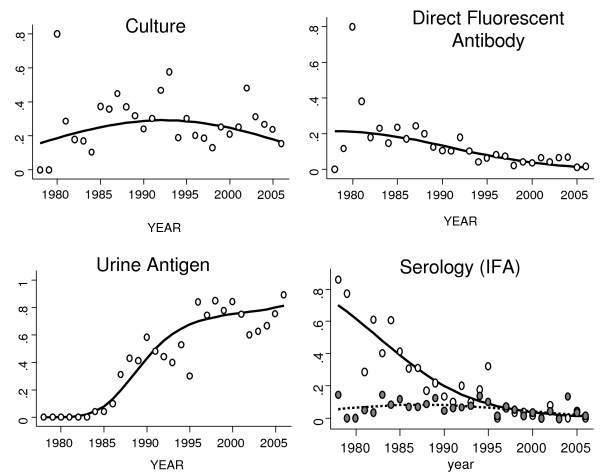
Changing Influence of Testing Methodologies on Legionellosis Diagnosis, Ontario, 1978–2006. Observed (dots) and expected (curves) probabilities of test positivity by methodology in 1401 cases of legionellosis diagnosed in Ontario, Canada from 1978 to 2006. In bottom right graph, solid line and white dots represent seroconversion based on paired serological testing, while broken line and gray dots represent diagnosis based on single high-titre positive serology. Expected probabilities are generated using logistic regression models, with probability of test positivity regressed against year and (in the case of culture and single high-titre immunofluorescent antibody) year-squared. Urine antigen testing was introduced at the laboratory in 1984, and consequently no specimen was positive by this method prior to that date.